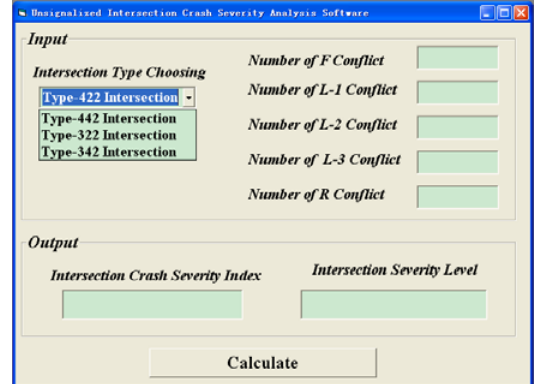
Fig.9. Crash Severity Analysis Software Interface